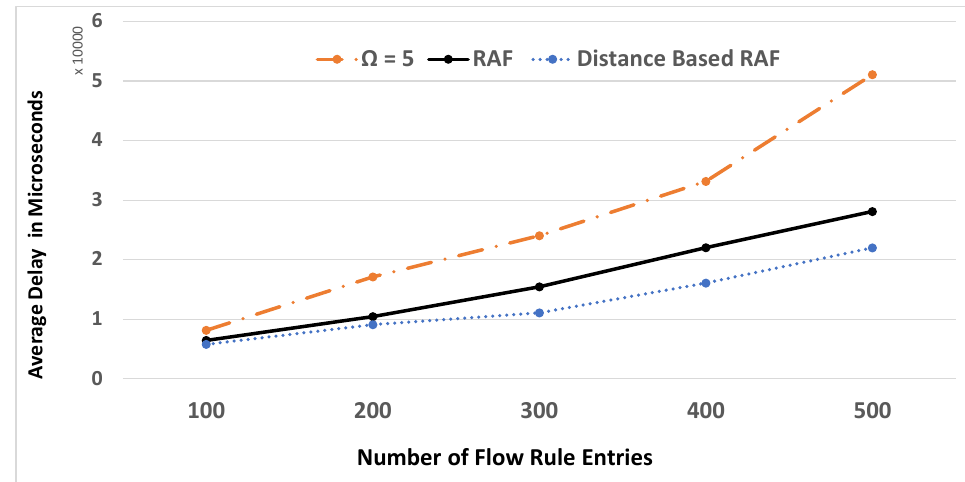
Figure 8. Average delay computed at the controller for the installation of computed flow rule entries. All or selected path installation procedures in the existing approaches install the use- less entries in the switch memory. Figure 9 presents the experimental results by accessing the packets and number of bytes entertained by the flow rule entries in switches, and it has yielded that RAF and DRAF are much more efficient for the said situation. The proposed approach is more efficient compared to the existing approaches, as it installs only useful entries in the switches (i.e., flow rule entries with continuous packet processing counter